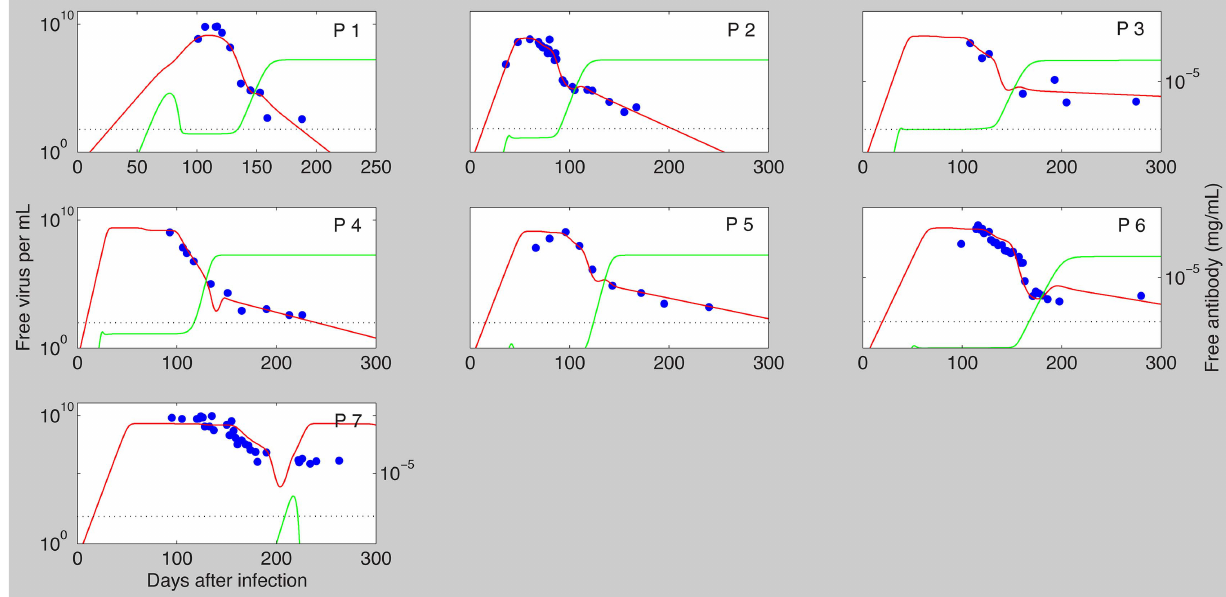
Figure 10. The viral load (red lines) and free antibody (green lines) predicted by model (30). The dotted line represents the antibody limit of detection of 0 : 1 ng per mL. Best parameter estimates are presented in Table 3. k p ~ 10 { 10 per molecule per day, A m ~ 4 | 10 11 molecules per mL, c ~ 1 : 67 per day, c AV ~ 4 c per day and the other parameters are as in Table 1. Patient data is represented by blue symbols.